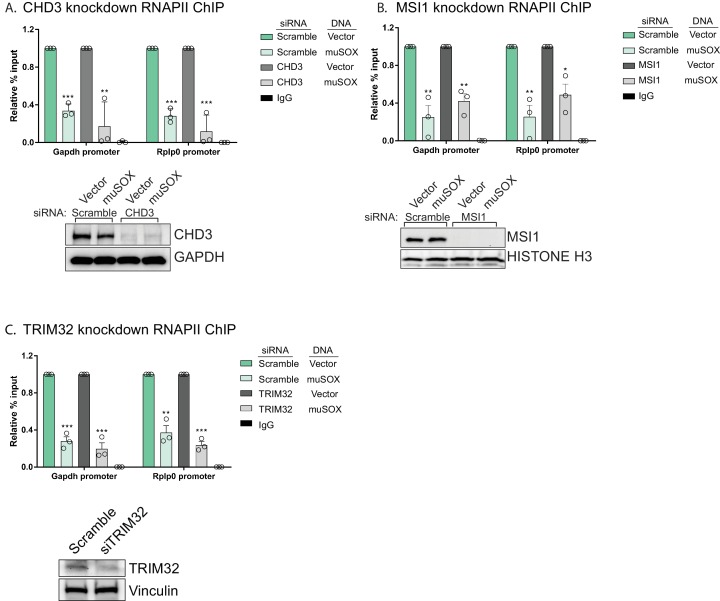
PABPC is required for the connection between cytoplasmic mRNA decay and RNAPII promoter occupancy.(A,C) HEK293T cells were treated with siRNAs targeting CHD3 (A), MSI1 (B), or TRIM32 (C), or non-targeting scramble siRNAs, then transfected with either empty vector or muSOX and subjected to chromatin immunoprecipitation (ChIP) using antibodies to RNAPII or IgG. Purified chromatin was quantified by qPCR. Western blots showing the levels of CHD3 and MSI1 after siRNA depletion, along with a GAPDH or histone H3 loading control are shown below. Graphs display individual biological replicates as dots, with the mean and SEM. Statistical significance was determined using Student’s t test *p<0.05 **p<0.005 ***p<0.0005.